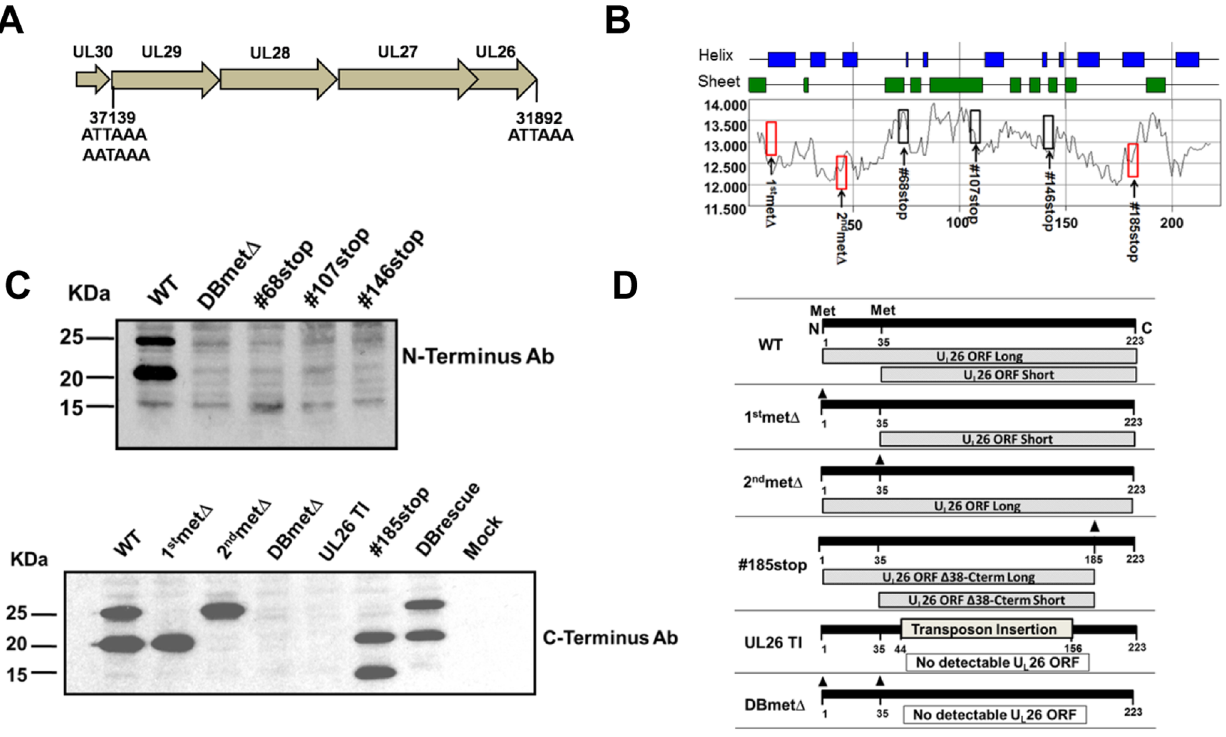
Figure 1. Creation of U L 26 mutant viruses. ( A ) Schematic of the HCMV U L 30-U L 26 genomic region. ( B ) A Manavalan hydrophobicity plot of the U L 26 protein with the positions of specific methionine mutations or stop insertions illustrated. In blue and green, are Chou-Fassman predicted secondary structure domains. BAC-engineered stop and start mutations are overlaid, with red boxes indicating stable U L 26 protein accumulation, and black boxes indicating lack of stable U L 26 protein accumulation. ( C ) Accumulation of viral proteins after HCMV infection. Replicate cultures of fibroblasts were mock infected or infected with WT, 1 st met D , 2 nd met D , DBmet D , UL26TI, DBrescue or stop codon mutants: # 68stop, # 107stop, # 146stop and # 185stop virus (MOI=3). Cells were harvested at 48 hr post infection and processed for Western blotting using a U L 26-specific monoclonal antibody (targeting the N-terminus or C-terminus of U L 26 as indicated). ( D ) Illustration of the panel of U L 26 mutant viruses analyzed with the resulting U L 26 open reading frames (ORFs) indicated.